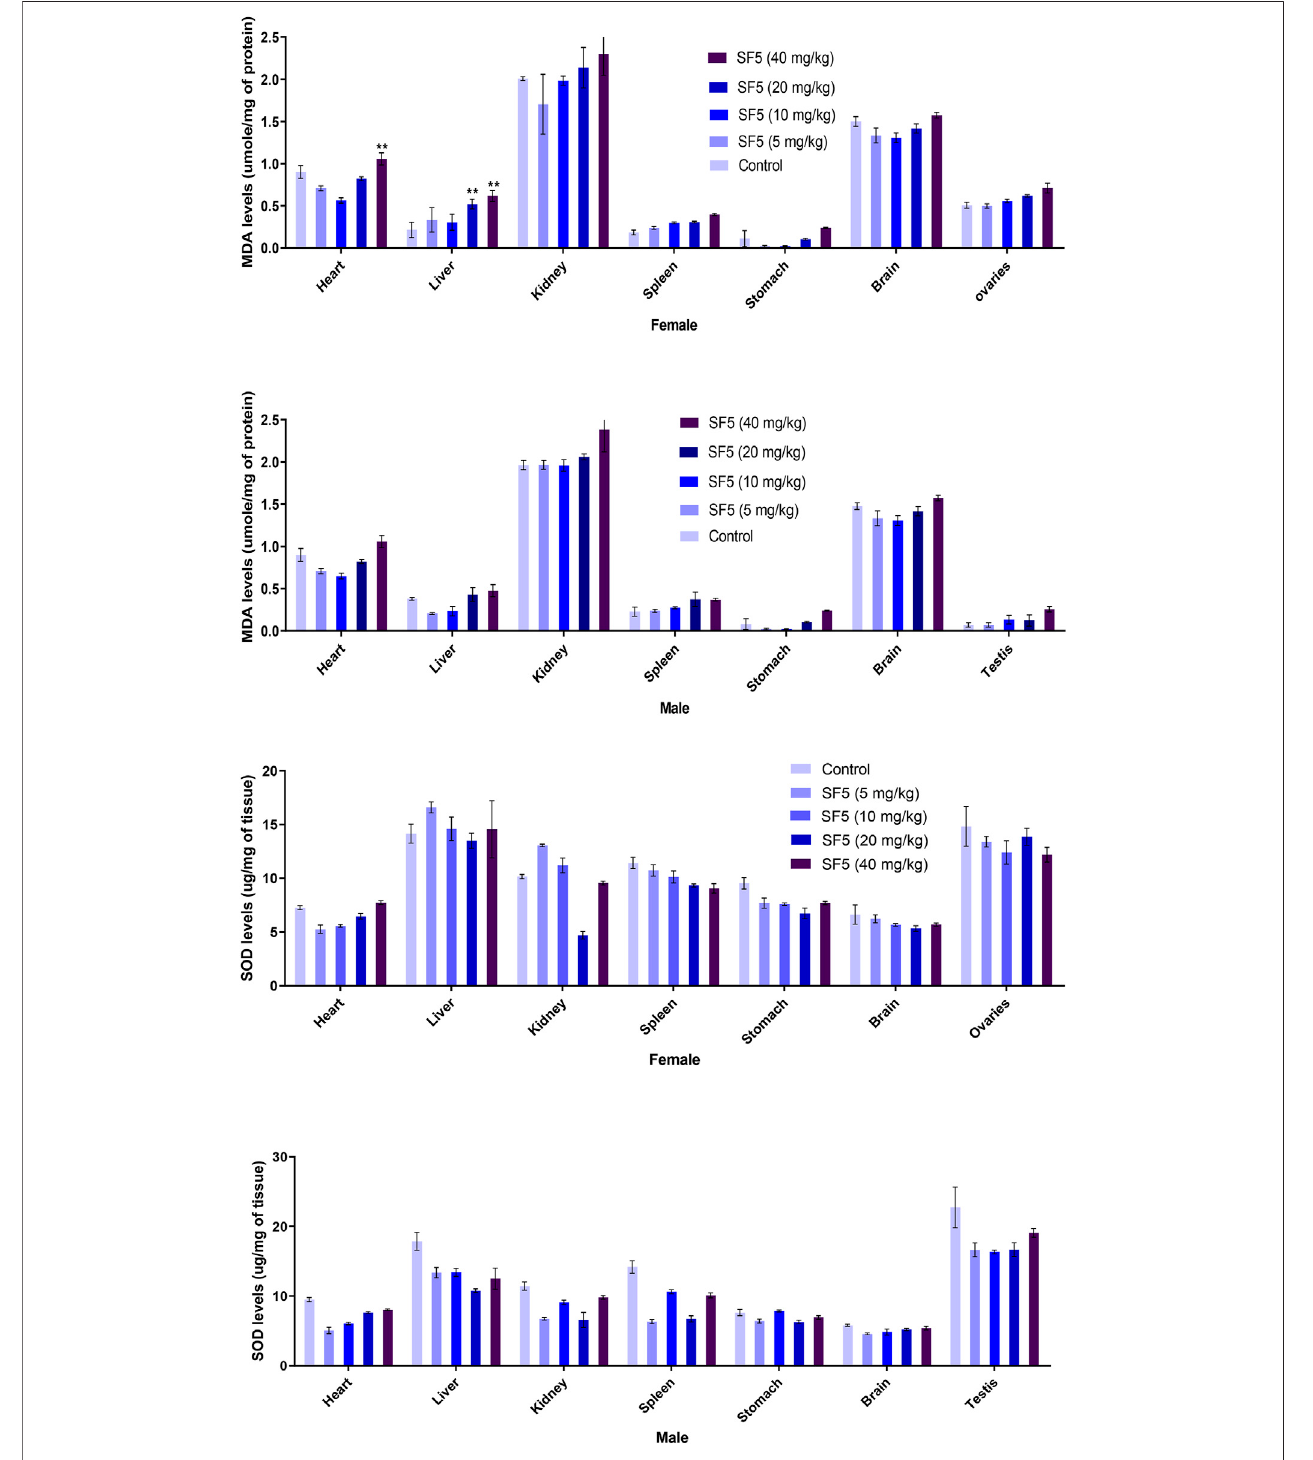
FIGURE7| Estimationofoxidativestressmarkersinthesubacutetoxicitystudyinmaleandfemalerats.Dataarepresentedasmean ± SEM, n (cid:1) 3.* p < 0.05isthe increase in the level of signi fi cance while ^ p < 0.05 is the level of decrease in comparison to the control.